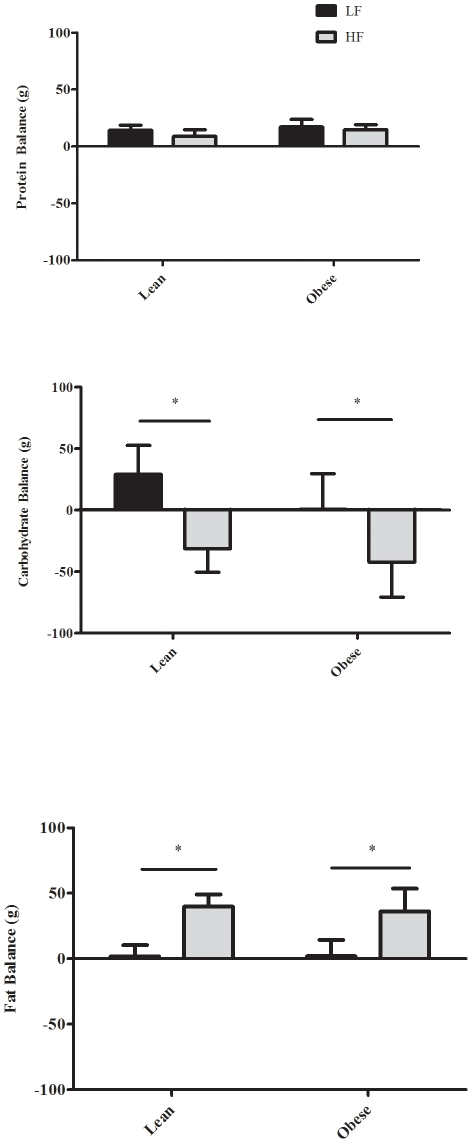
Mean (± SE) 24 h (g/day) protein (Top), carbohydrate (Middle), and fat (Bottom) balance measured using room calorimetry during LF (black bars) and HF (grey bars) in LN (N = 10) and OB (N = 9).* LF significantly different from HF (P<0.05).